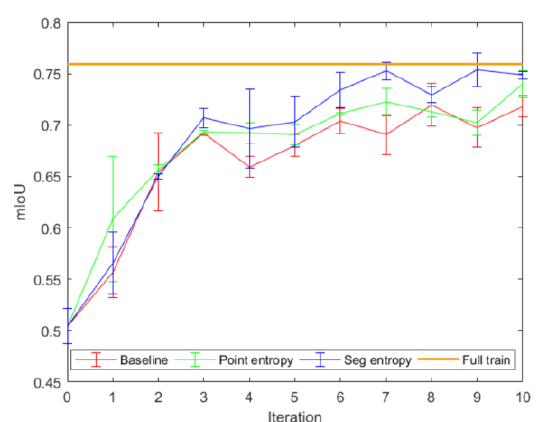
Figure 4. Mean IoU scores of baseline and active learning strategies with different query functions. The horizontal axis represents the iteration. Error bars represent standard Table 1. Parameter setting of multiple grouping modules in PointNet++